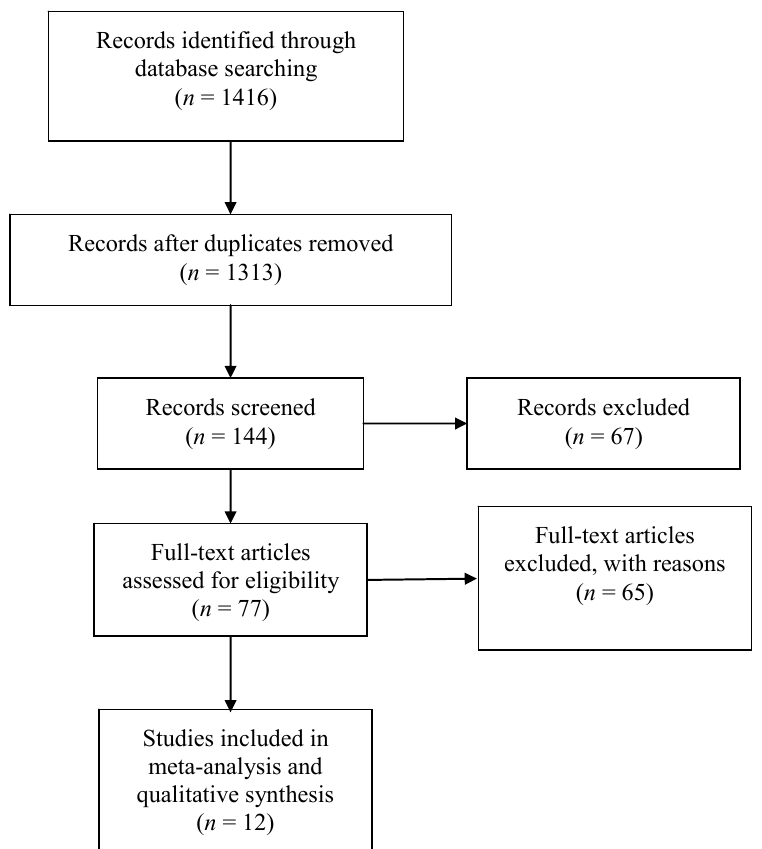
Figure 1. Flow diagram outlining the selection procedure to identify articles which were included in the analysis of psychological interventions in SARS-CoV-2 pandemic